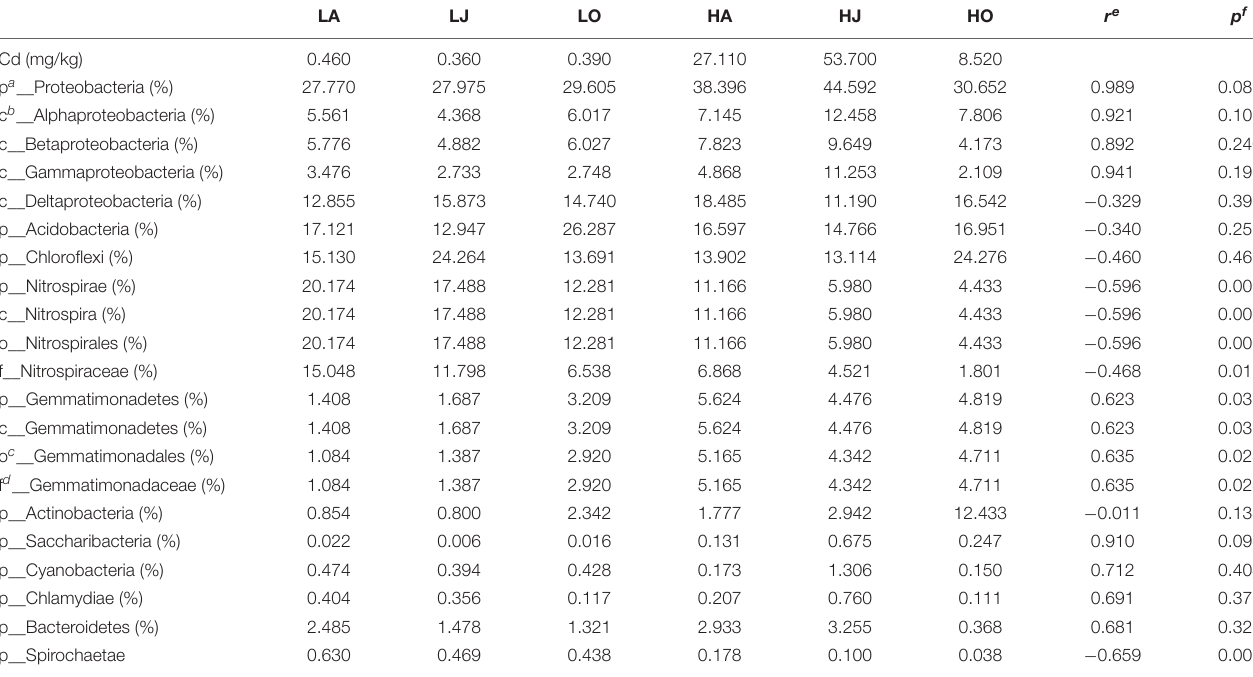
TABLE 2 | Pearson correlation and t-test analysis of the relative abundance of microbial phyla, classes, and cadmium